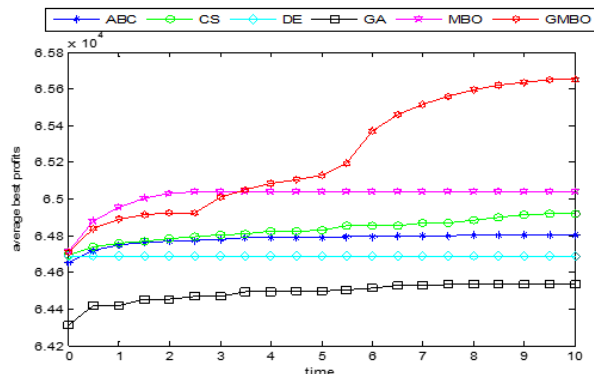
Figure 22. The convergence graph of six methods on KP10 in 10 seconds.